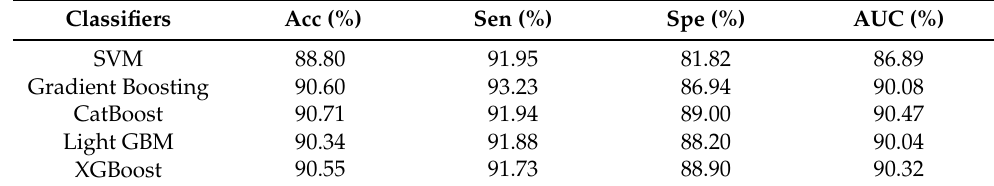
Table 9. Performance of each classifier with the 48 selected features in the 60 s